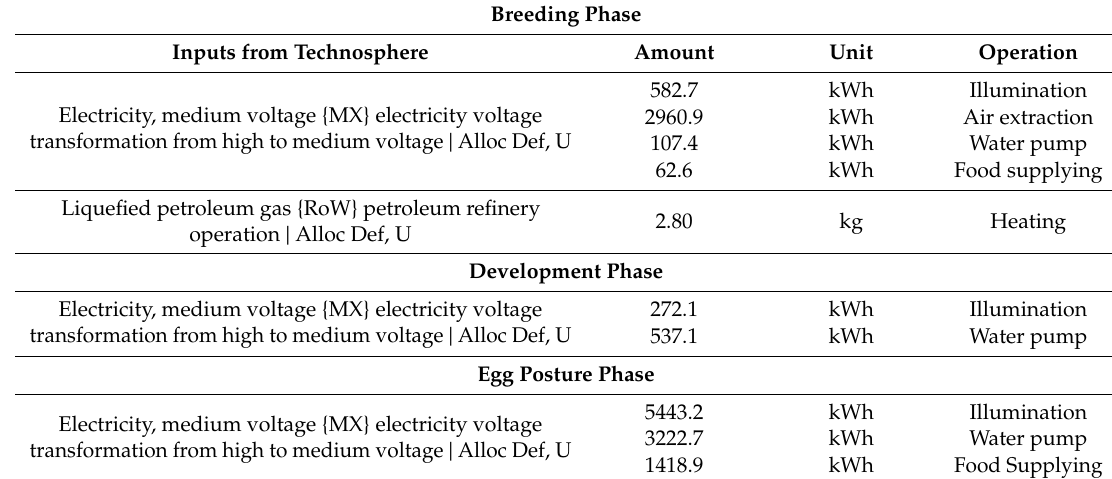
Table 4. Fuel inventory database from poultry farm per production